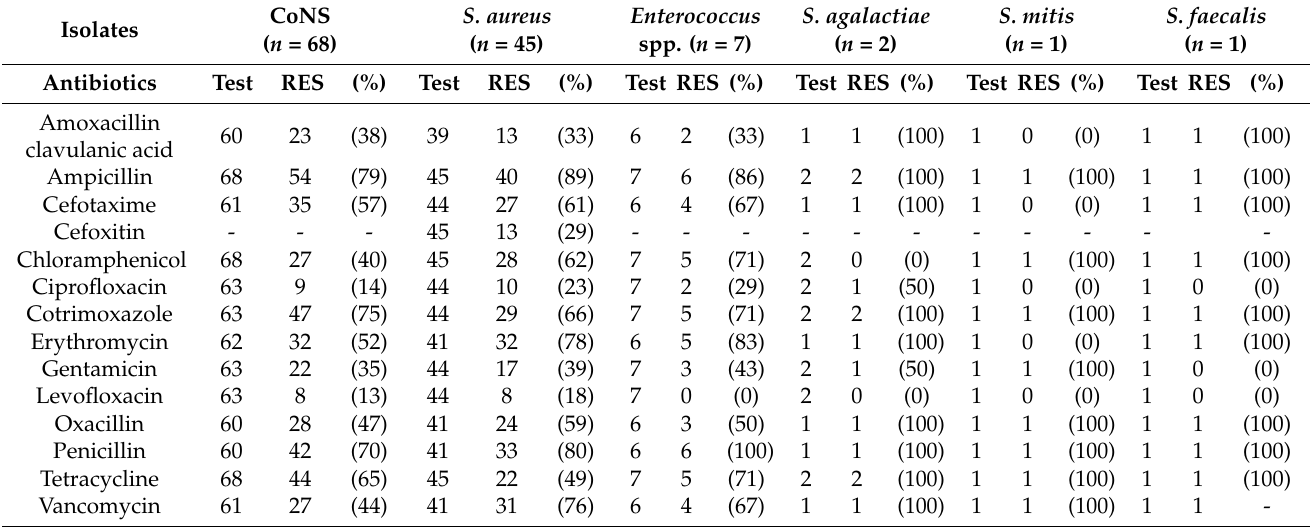
Table 3. Antibiotic susceptibility testing patterns of Gram-positive isolates ( n = 124) among neonates with culture-confirmed sepsis at the 37 Military Hospital, Accra, Ghana (2017–2020).